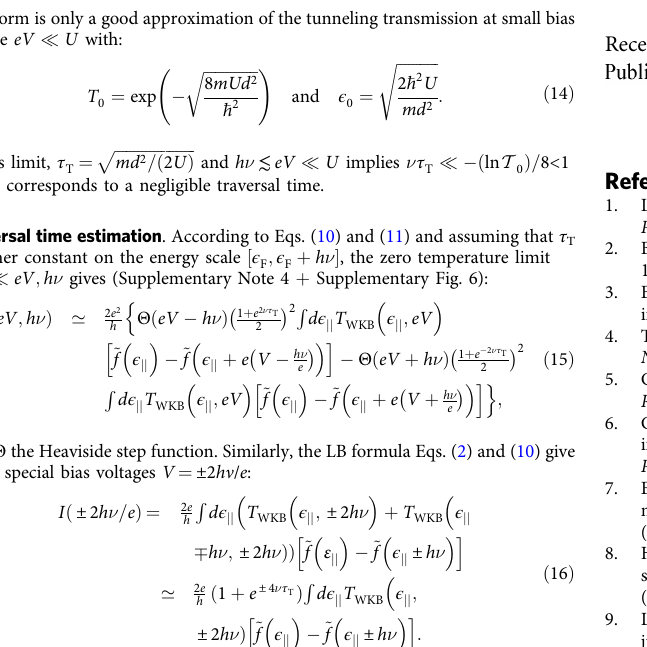
Received: 2 April 2018 Accepted: 25 October 2018